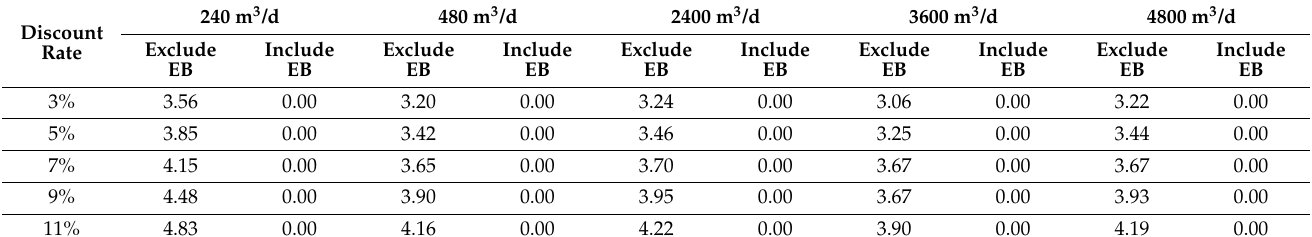
Table 6. Minimum selling price of reclaimed water (THB) for water reclamation projects for the irrigation of plants and green areas when including and excluding environmental benefits